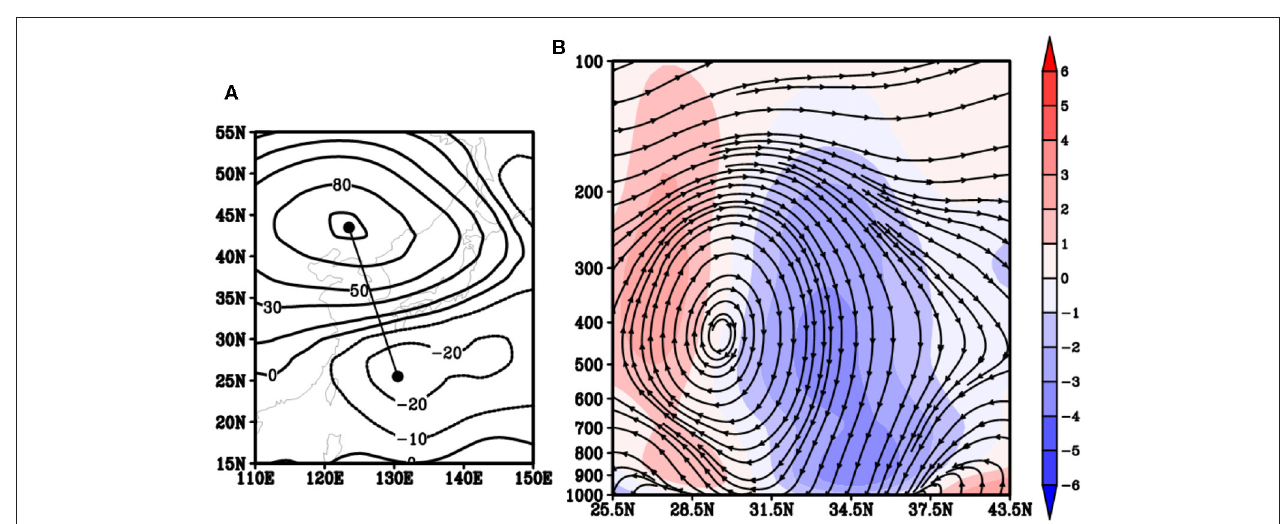
FIGURE 7 | The values averaged from July 18th to August 5th of 2018 for (A) the 500 hPa geopotential height anomalies (gpm) where the straight line runs between the center of the local high and typhoon and (B) the secondary vertical circulation over the local high and typhoon centers, where the streamlines denote the vertical circulation formed by horizontal divergent winds and by vertical motion over the line connecting the centers. Shading represents the vertical velocity (Pa.s − 1 ).